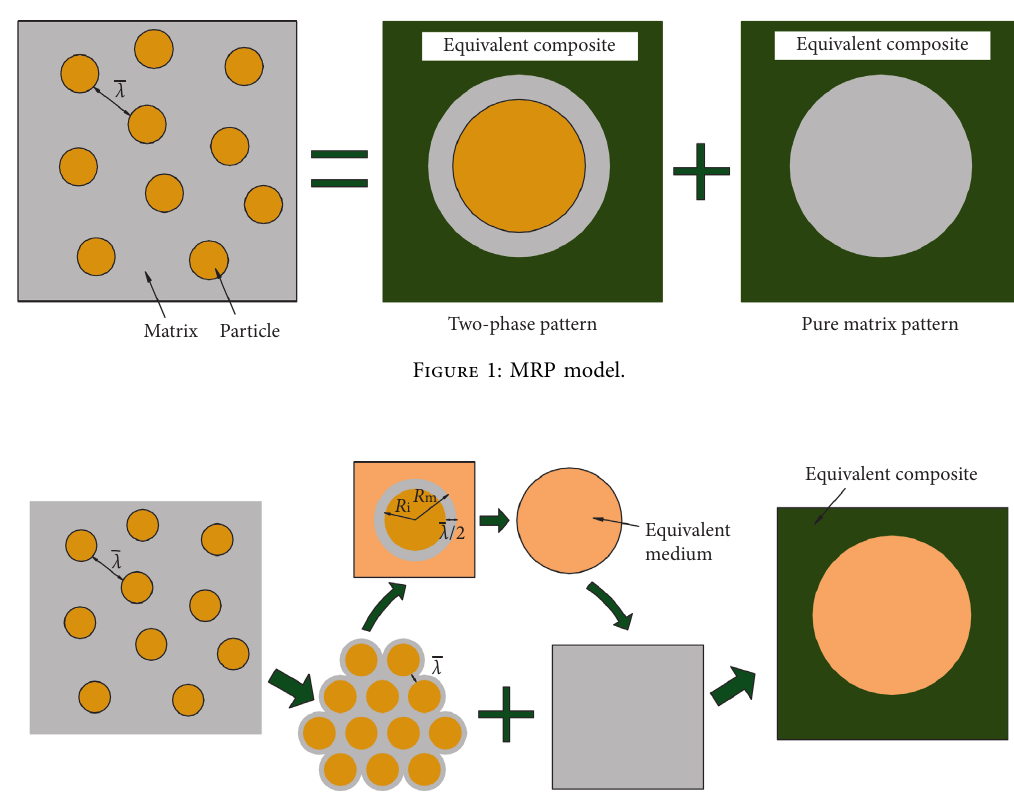
Figure 2: Homogenized MRP model (H-MRP